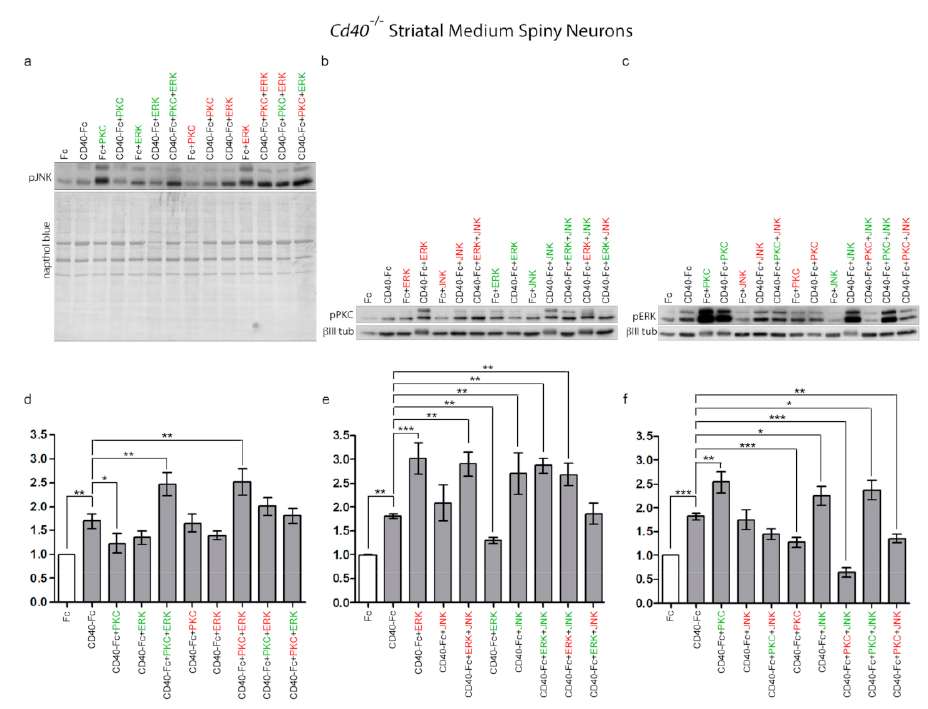
Figure 4. Regulation of JNK, PKC, and ERK1/ERK2 phosphorylation by pharmacological reagents in MSNs in the presence and absence of CD40L reverse signalling. ( a – c ) Representative western blots of lysates of MSNs of Cd40 − / − E14 embryos cultured for 9 days and treated for 20 min with either 1 µ g/mL control Fc or 1 µ g/mL CD40-Fc in combination with activators (green) and inhibitors (red) of PKC, JNK, and ERK as indicated. The concentrations were the same as those indicated in Figure 2. The western blots were probed with anti-pJNK after treatment with activators and inhibitors of PKC and ERK1/ERK2 ( a ), anti-pPKC after treatment with activators and inhibitors of ERK1/ERK2 and JNK ( b ), and anti-pERK1/pERK2 after treatment with activators and inhibitors of PKC and JNK ( c ). Anti- β III tubulin was used to normalize western blots of cytosolic fractions and Naphthol blue for the nuclear fractions. ( d – f ) Quantification of at least three independent western blots. The grey bars show combined treatments in the presence of 1 µ g/mL CD40-Fc, and the white bar, the control with 1 µ g/mL Fc. The mean ± s.e.m are indicated (*** p < 0.001, ** p < 0.01, and * p < 0.05, one-way ANOVA with multiple Newman–Keuls statistical